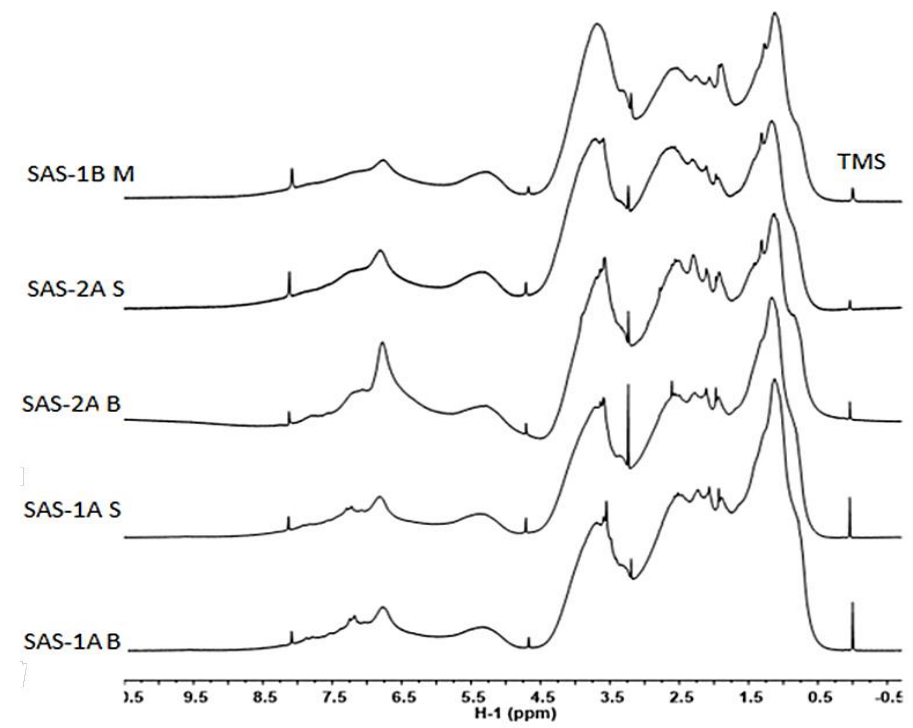
Figure 5. Liquid-state 1 H NMR spectra of all PPL-DOM SAS samples. Chemical shifts were referenced in Table 1. H NMR spectra were similar and indicated a relatively low aromatic content compared to peptide/carbohydrate, carboxyl-rich alicyclic molecules (CRAM), and aliphatic content. However,